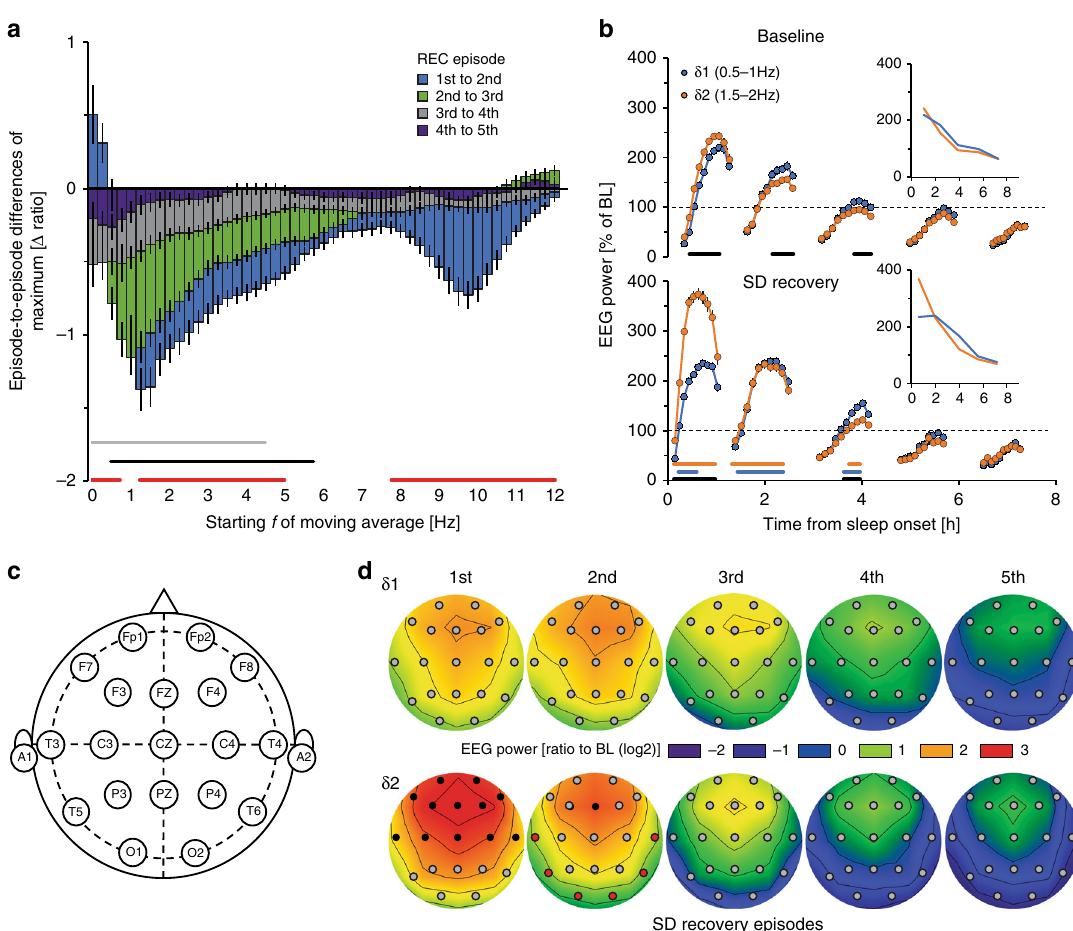
Fig. 6 δ -band heterogeneity in humans. a Differences between consecutive recovery (REC) NREMS episodes in highest EEG power reached per episode [three 0.25Hz-bin moving average per quantile; see B; 1st – 2nd (blue), 2nd – 3rd (green), 3rd – 4th (gray), and 4th – 5th (dark blue)] following a 40-h sleep deprivation (SD). The largest decrease was observed in faster δ (1.5 – 2.0 Hz), while activity in slower δ (0.5 – 1 Hz) increased initially (two-way rANOVA factors episode-to-episode differences × frequency: F 48,10464 = 13.6, p = 1.0E-17, n = 110). Red, black, and gray lines represent post-hoc signi fi cance ( p < 0.05), 2nd/1st, 3rd/2nd, and 4th/3rd NREMS episode, respectively. Data is expressed as means± s.e.m. b Time-course plots of δ 1- (0.5 – 1.0 Hz) and δ 2- (1.5 – 2.0 Hz) power during each NREMS episode (10 quantiles/episode) in baseline conditions (BL; top) and recovery (bottom). Gaps re fl ect intervening wake or REMS. During BL, signi fi cant δ 1- δ 2 differences were seen (two-way rANOVA factors sub-band × time-course: F 49,10437 = 8.6, p = 1.0E-17). After SD, δ 2 was increased during the fi rst NREMS episode, illustrated by the time-course of maximum values per episode (insert; REC: two-way